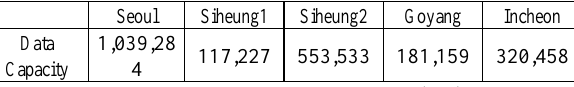
Table 1. Experiment data capacity (KB)